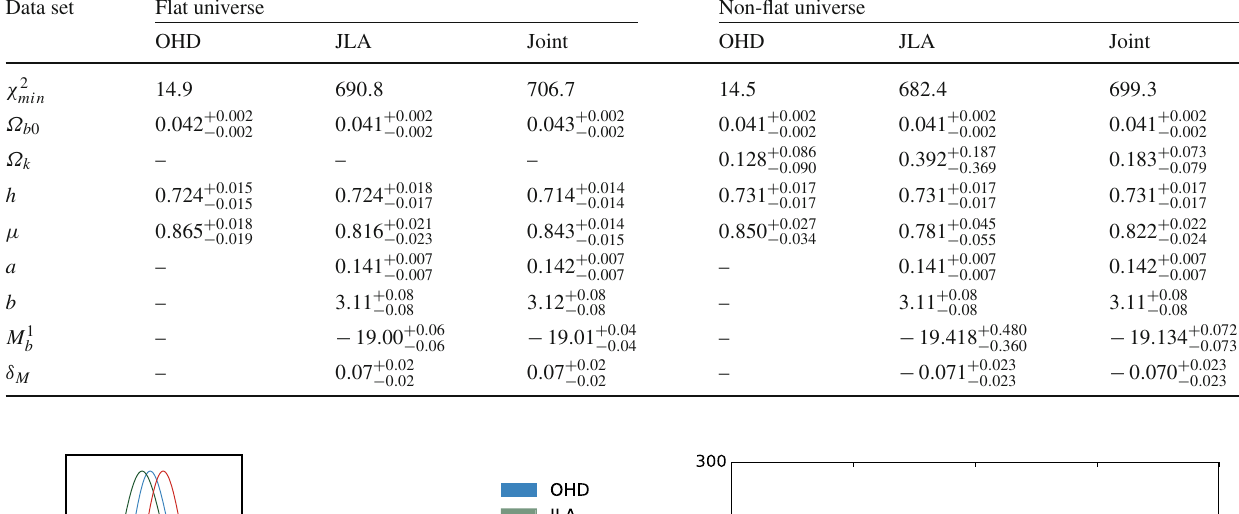
Table 1 Mean values for the model parameters ( Ω b 0 , Ω k , h , μ ) derived from OHD and SNIa measurements for a flat universe (left side) and non-flat one (right side)